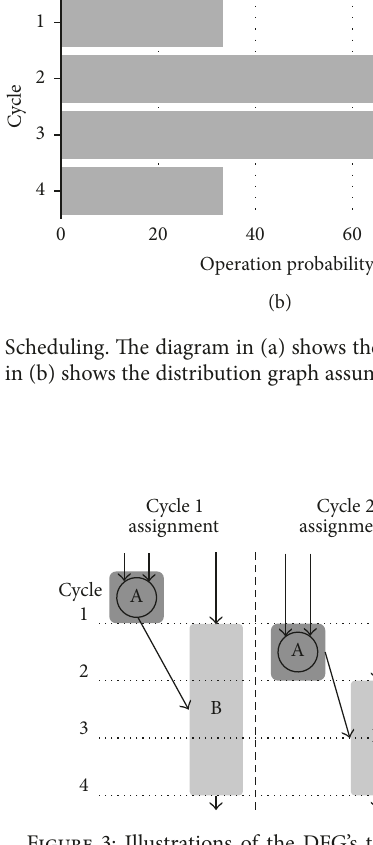
Figure 3: Illustrations of the DFG’s time frames after a tentative assignment of operation